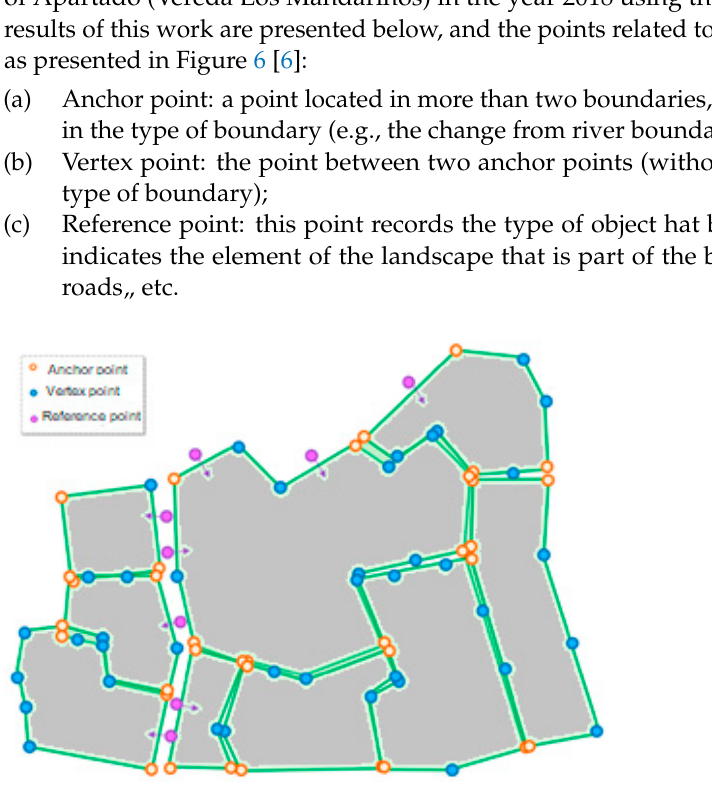
Figure 6. Types of points in the FFP methodology. Source [14]